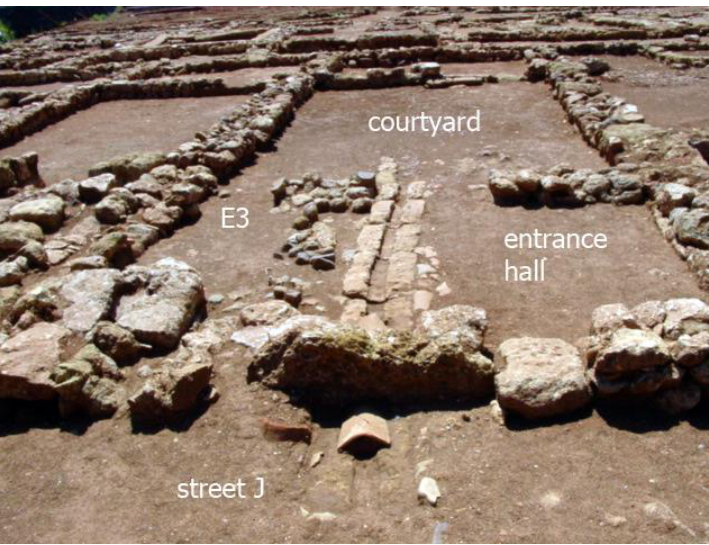
Figure 5. House 103. Plan and room distribution.